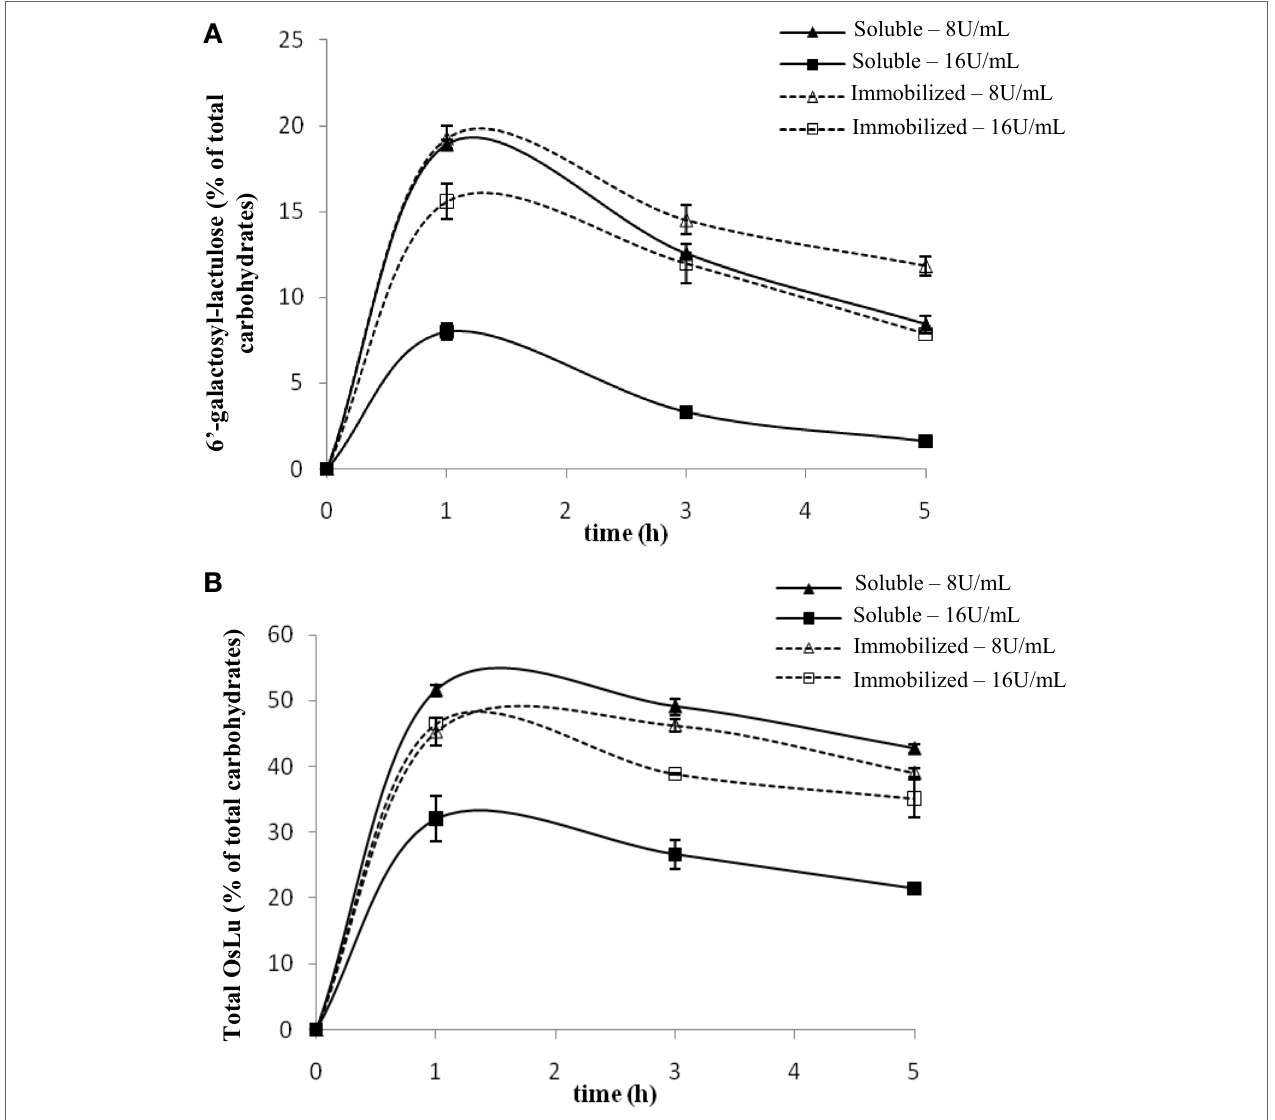
FigUre 2 | effect of enzyme concentration on (a) 6 ′ -galactosyl-lactulose and (B) total Oslu production during the enzymatic hydrolysis of lactulose (450 g/l) with soluble (continuous line) and immobilized (dotted line) A. oryzae β -galactosidase in 0.1 M buffer sodium phosphate ph 6.5 at 50 °c: ( ▴ , ∆ ) 8 U/ml; ( ▪ , ◻ ) 16 U/ml